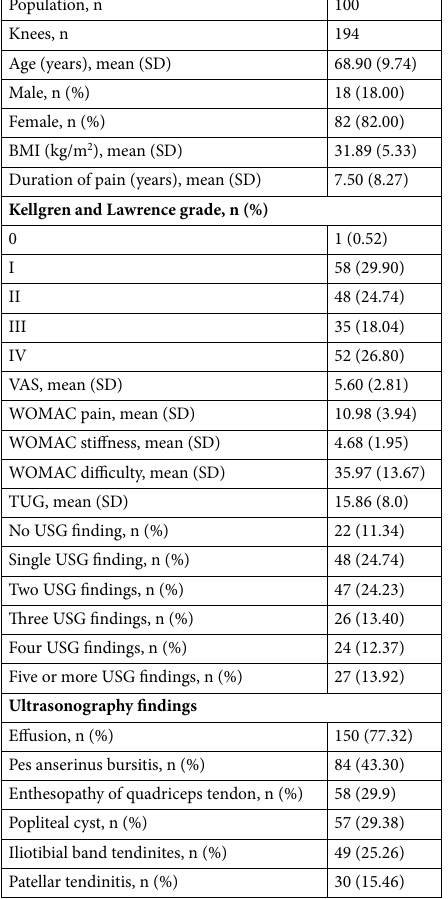
Table 1. Demographics. n number, % percentage, SD standard deviation, BMI body mass index, kg/m 2 kilograms per meter 2 , VAS visual analogue scale, USG ultrasonography, WOMAC Western Ontario